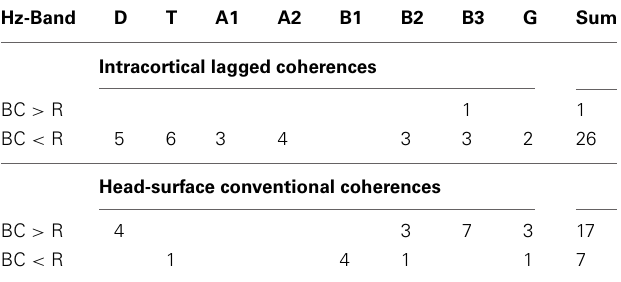
Top: Intracortical lagged coherences. Bottom: Head-surface conventional coher- ences. Hz-Band, EEG frequency band; D, delta; T, theta; A1, alphsa-1;